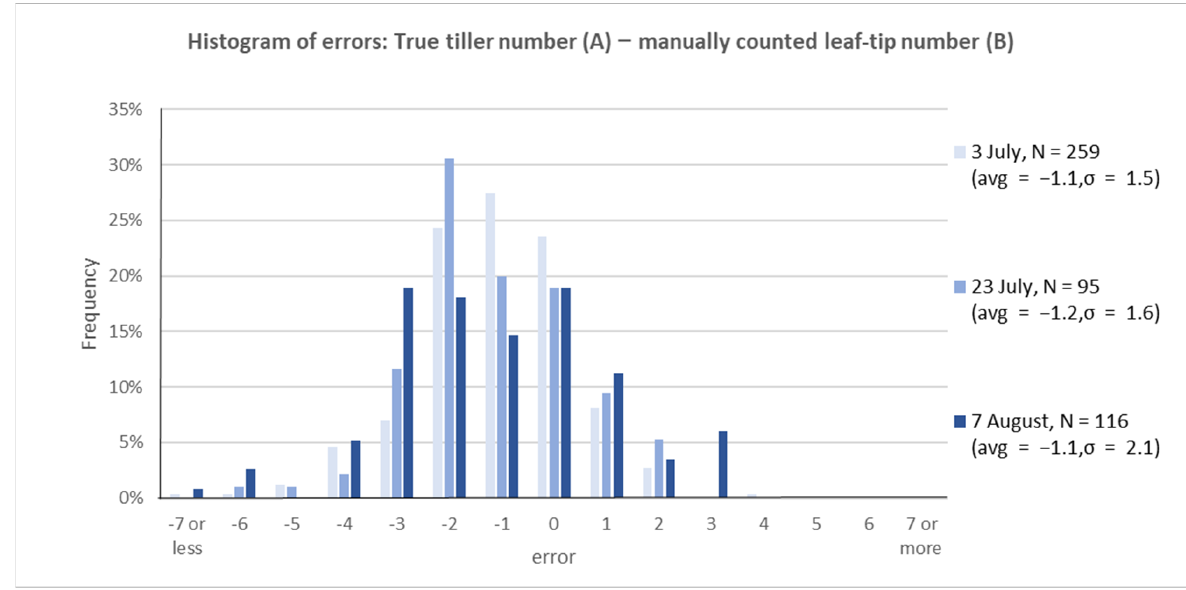
Figure 8. Histogram of errors between true tiller number and manually counted leaf-tip number counting (even if they were the same hill, different images were analyzed as another sample. The sample number is not consistent with that in Figure 7).